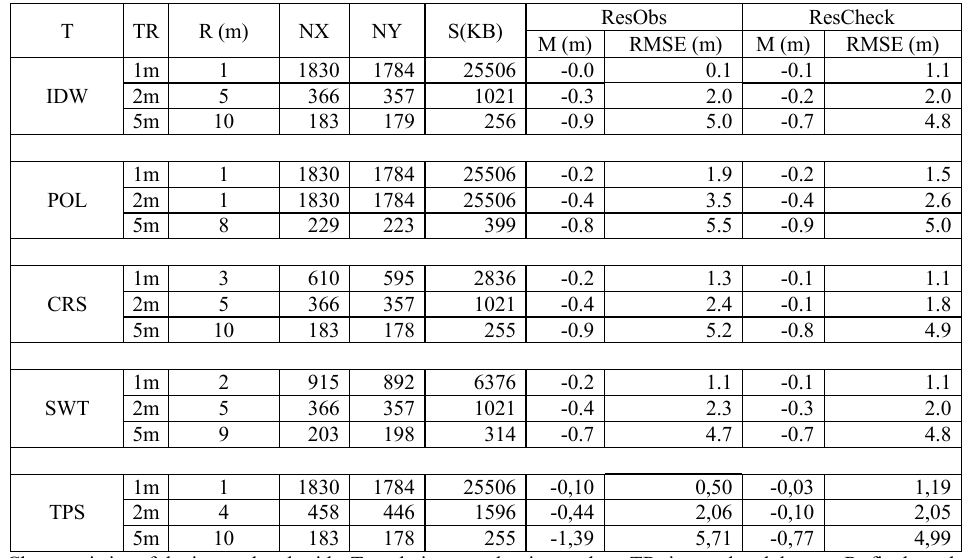
Table 3. Characteristics of the interpolated grids. T: technique used to interpolate; TR: interpolated dataset; R: final resolution; NX and NY: number of nodes in X and Y; S: storage size; ResObs, ResCheck: statistics of the residuals on the used observations and the check points; M: mean; RMSE: root mean square error. TR NSplines